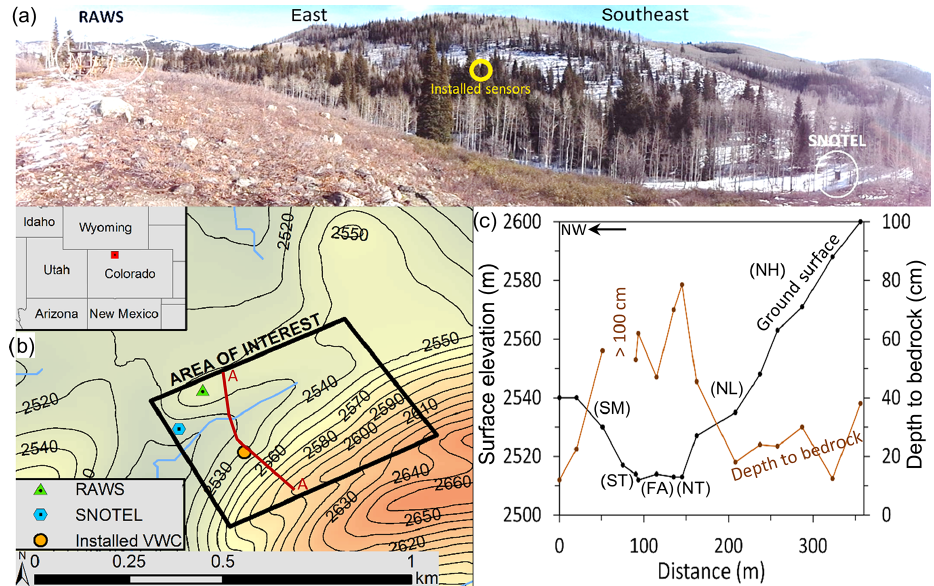
Figure 1. (a) Panoramic picture of the study area facing east to southeast. Location of photo taken to the west of Remote Automated Weather Station (RAWS) location in map (b) . Locations of the RAWS, SNOTEL station, and installed soil moisture sensors are circled and labeled. (b) Map of the study site and area of interest in this investigation. 10m contours are shown. (c) Cross section A–A from panel (b) showing the elevation of the ground surface and depth to bedrock using a 1m long hand auger. Regions of interest are identified as middle of the south aspect hillslope (SM), toe of the south aspect slope (ST), flat aspect (FA), toe of the north aspect slope (NT), low on the north aspect slope (NL), and high on the north aspect slope (NH). All ground surface data are from 10m resolution digital elevation model (USGS,